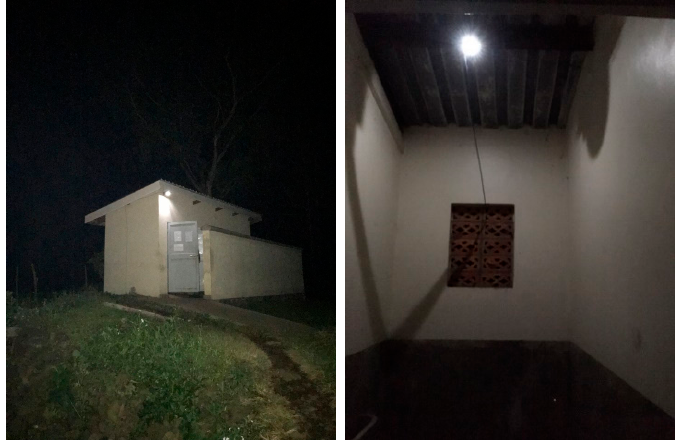
Figure 3. Photos of lights powered by the Pee Power system outside of a latrine block (left) and inside a toilet cubicle (right).